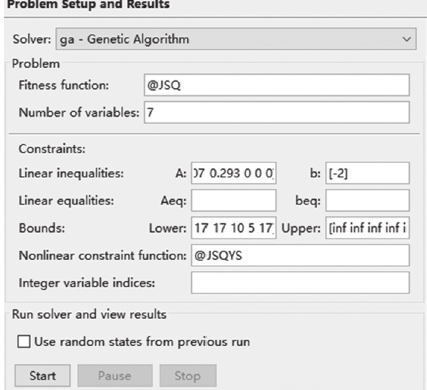
Figure 6: Genetic algorithm toolbox interface.